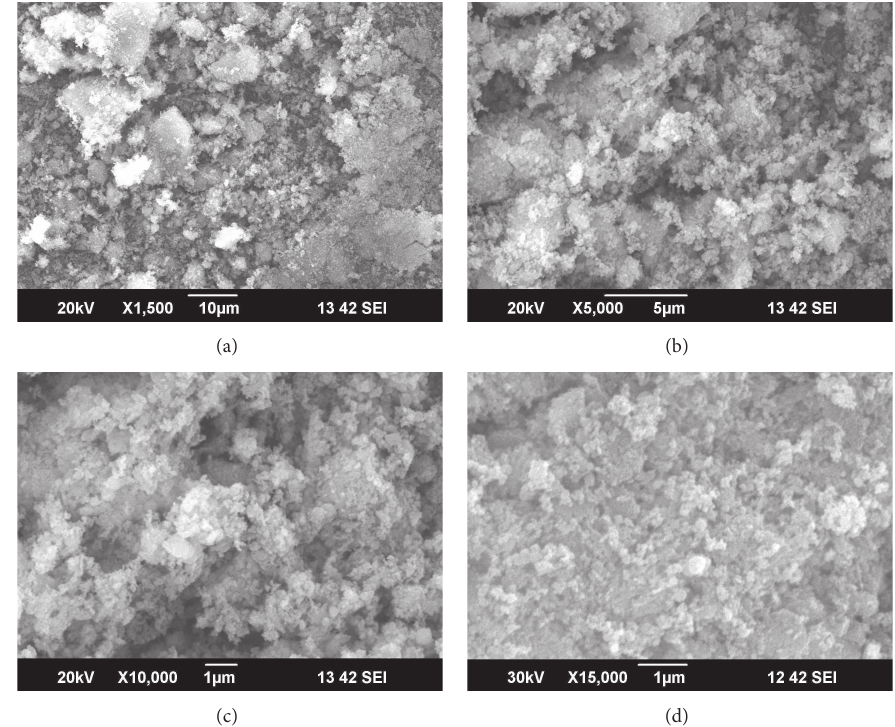
Figure 7: (a–d) SEM microimages of annealed MgO nanopowders obtained by combustion followed byannealing method.